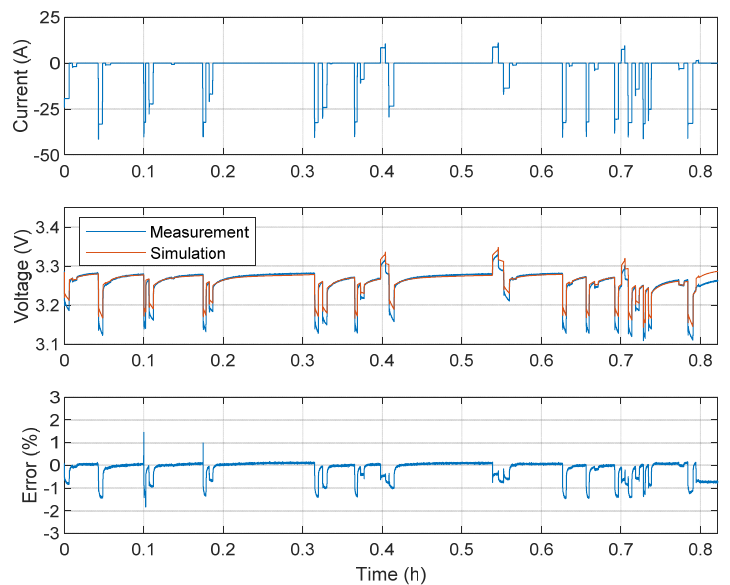
Figure 12. Lithium-ion battery validation test.